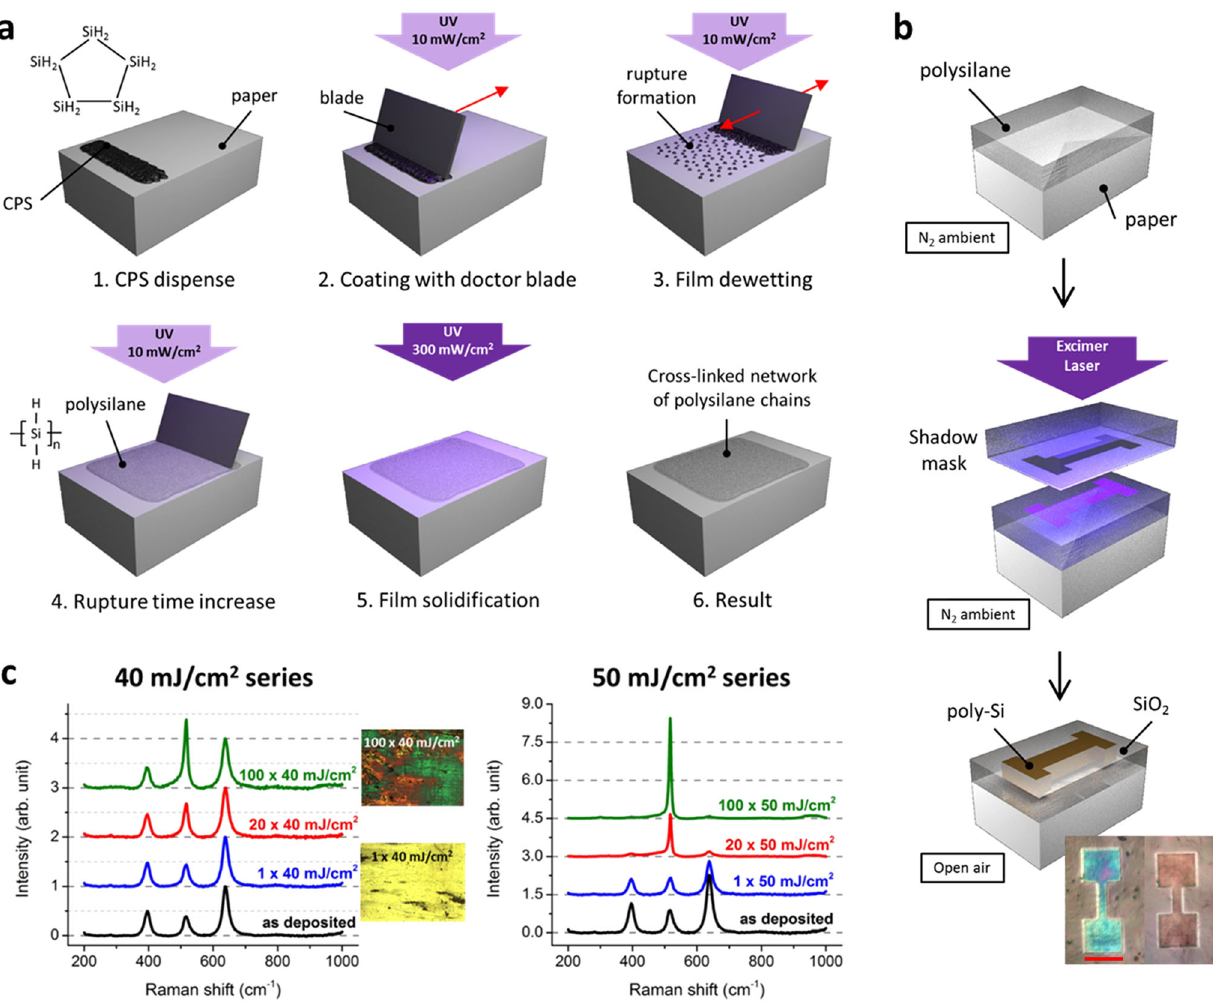
Fig. 1 Coating and crystallization of Si ink. a Diagram of the cyclopentasilane coating process on paper. Through continuous blade coating during UV polymerization, the liquid rupture time increases, resulting in an increasingly stable fi lm. By using a high-intensity UV freeze, the fi lm remains uniformly coated and is solidi fi ed. b Diagram of local crystallization of the polycrystalline silicon channel through a shadow mask, resulting in an additive patterning process. Red line in the microscope image inset indicates a size of 50 μ m. c Raman spectroscopy measurement results of different laser crystallization recipes indicating numbers of pulses from 1 to 100 at laser fl uences of 40 (left) and 50 (right) mJ/cm 2 . Crystallization observed by the increasing Raman signal at 520 cm − 1 . (Panel c reproduced with permission from ref.